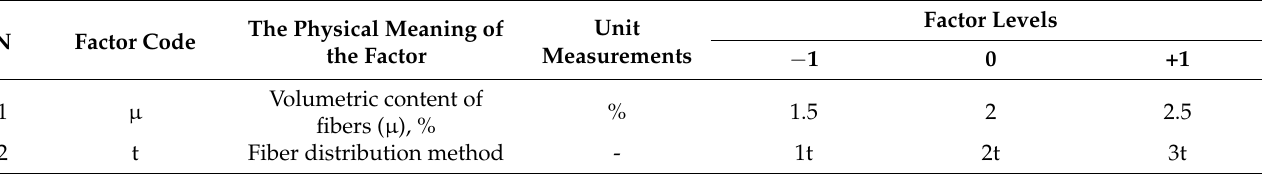
Table 10. Values of the variation factors of the FFE 2k.